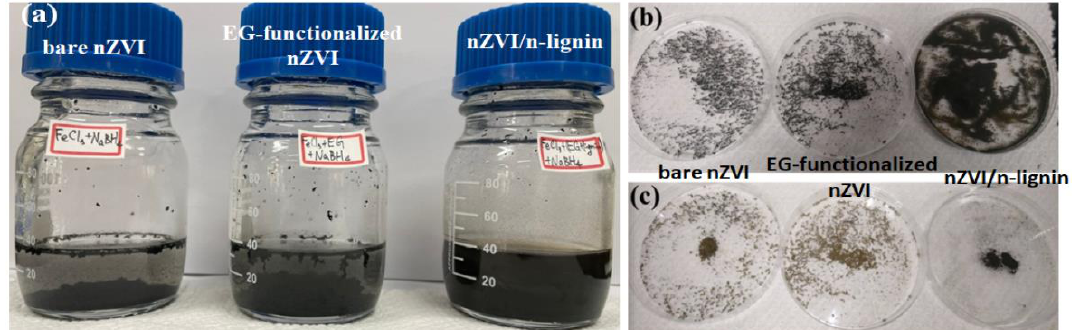
Figure 2. ( a ) After the synthesis for 30 min, the solution of the bare nZVI (left), EG-functionalized nZVI (middle), and nZVI/n-lignin (right). ( b ) After drying in the oven, the powders of the bare nZVI (left), EG-functionalized nZVI (middle), and nZVI/n-lignin (right). ( c ) After several weeks under atmospheric conditions, the powders of the bare nZVI (left), EG-functionalized nZVI (middle), and nZVI/n-lignin (right).